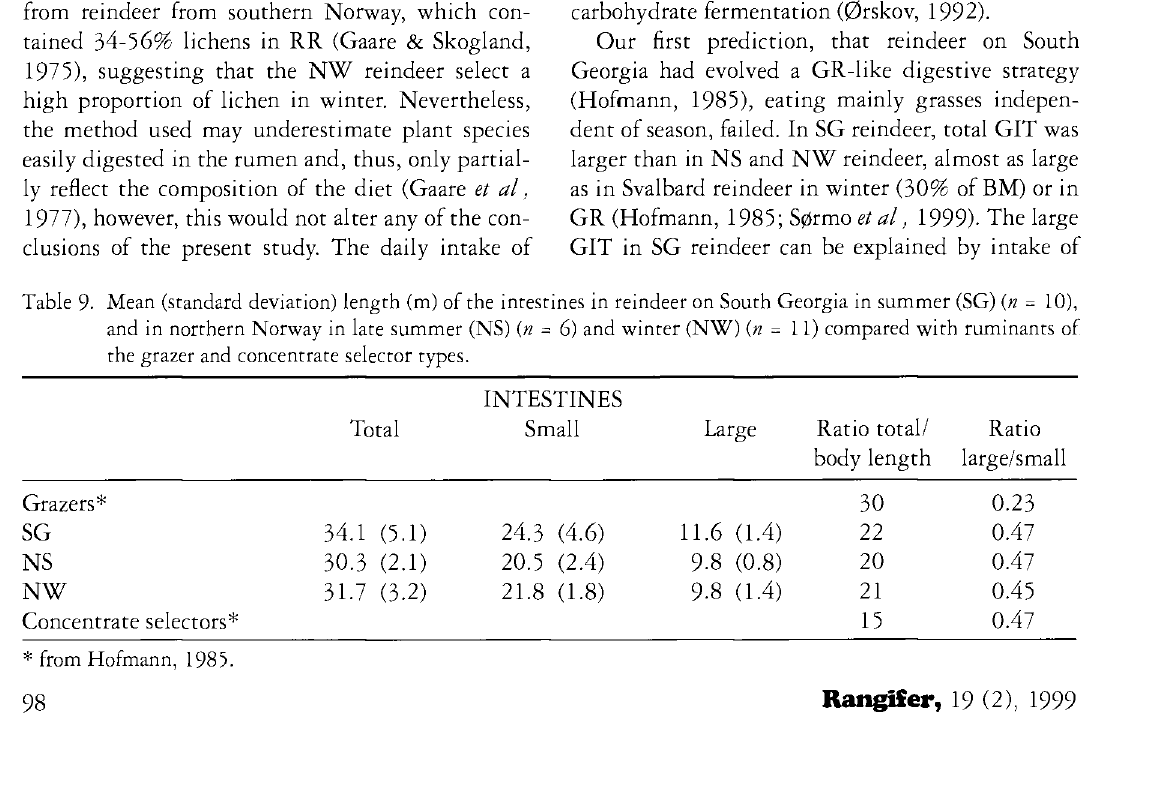
Table 8. Omasum/abomasum wet weight ratio and DFC/ reticulo-rumen wet content ratio in rein deer on South Georgia in summer (SG) (» = 10), and in northern Norway in late summer (NS) (n = 6) and winter (NW) (n = 11) compared with grazers and concentrate selectors.